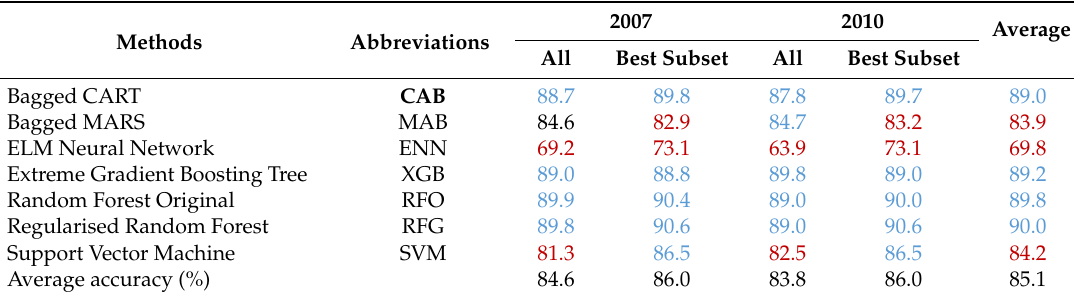
Table 4. The accuracy of classification over seven algorithms in 2007 and 2010 generated from all variables and the best subset. The blue colour indicates accuracies above the average; the red colour signifies accuracies below the